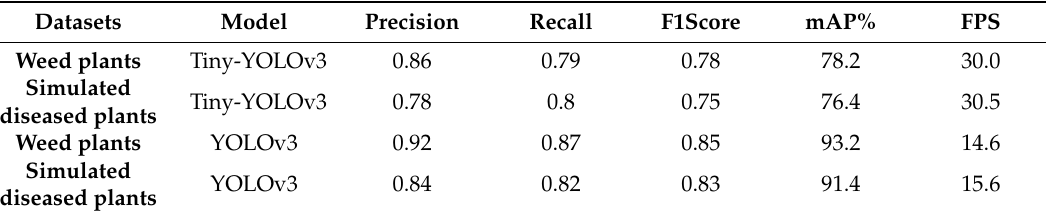
Table 3. Results of tiny-YOLOv3 and YOLOv3 models for both weed and simulated diseased plants datasets.